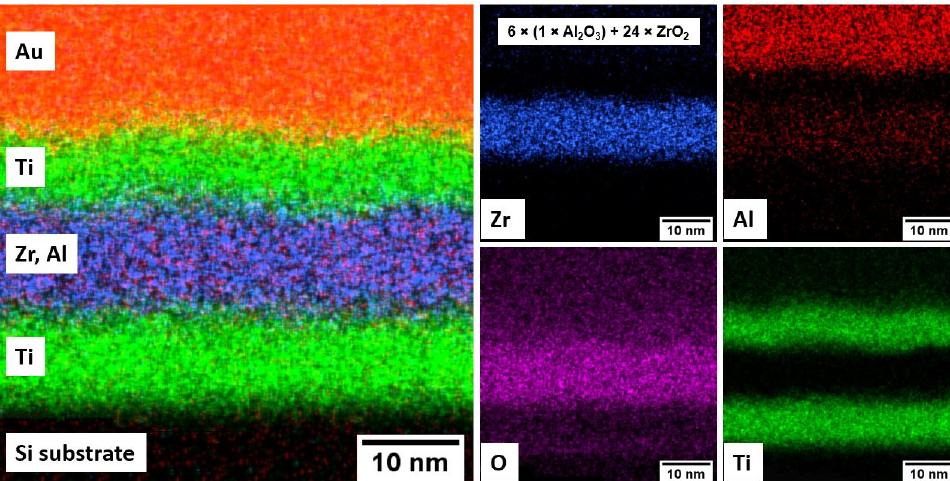
Figure 5. Elemental composition mapping of an Au/Ti/ZrO 2 :Al 2 O 3 /TiN stack containing ZrO 2 :Al 2 O 3 film deposited using the ALD cycle sequence of 6 × (1 × Al 2 O 3 + 24 × ZrO 2 ). The chemical elements (Au [orange], Ti [green], Zr [blue], Al [red] and O [magenta]) as detected and mapped are indicated by the corresponding labels. Note that the high intensity of the Al signal in the Au contact region is due to the X-ray continuum. The intensity of the X-ray continuum is higher in regions with high atomic numbers. Although the X-ray continuum contributes to all maps, the effect is especially pronounced in the Al map due to low concentration of Al and, as a result, low signal/background ratio. Figure 6 represents X-ray diffraction patterns of the double-layer Zr x Al y O z -ZrO 2 those deposited as multilayer ZrO 2 :Al 2 O 3 structures. The 10–15 nm thick ZrO 2 layers ob- tained in the Zr x Al y O z -ZrO 2 structures after applying 80 ALD cycles were ordered in the